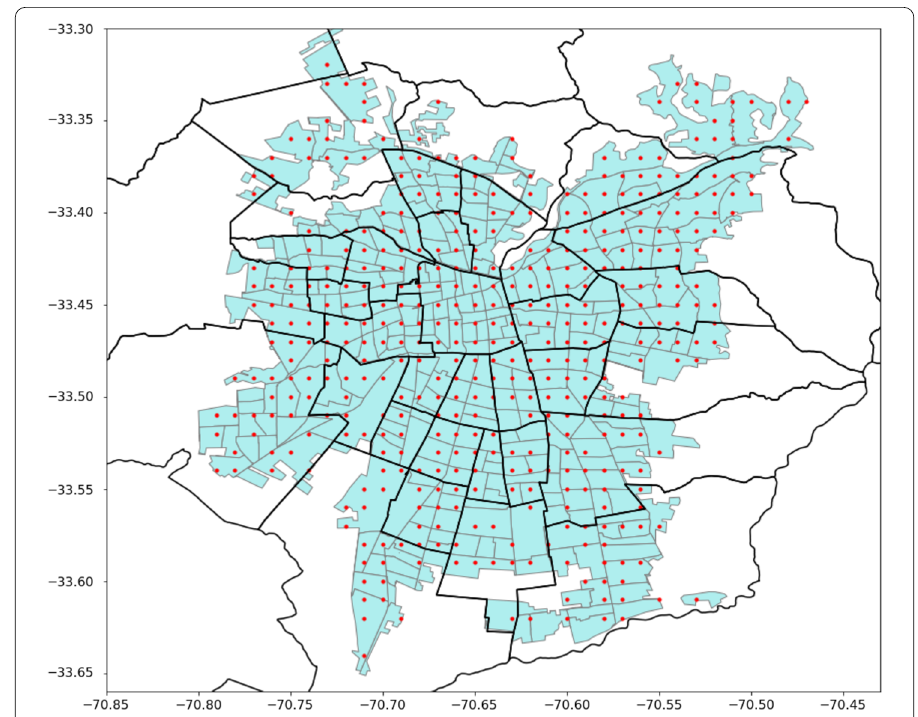
Figure 2 Census districts, comunas and dummytowers in the urban area of Santiago. The census data is available at a level of censusdistricts , the small areas surrounded by white borders. In the Figure are also shown the boundaries of the comunas (black lines), the administrative areas into which the city is divided. The red dots represent the dummy towers, obtained by clipping the coordinates of each antennas to the second decimal digit. All the traffic flow outgoing from each antenna was aggregated in the dummy towers to which it